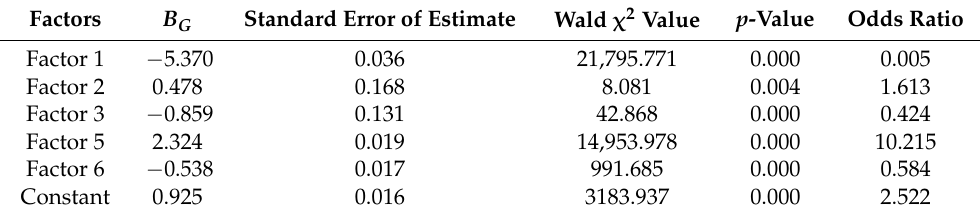
Table 9. The factors estimated